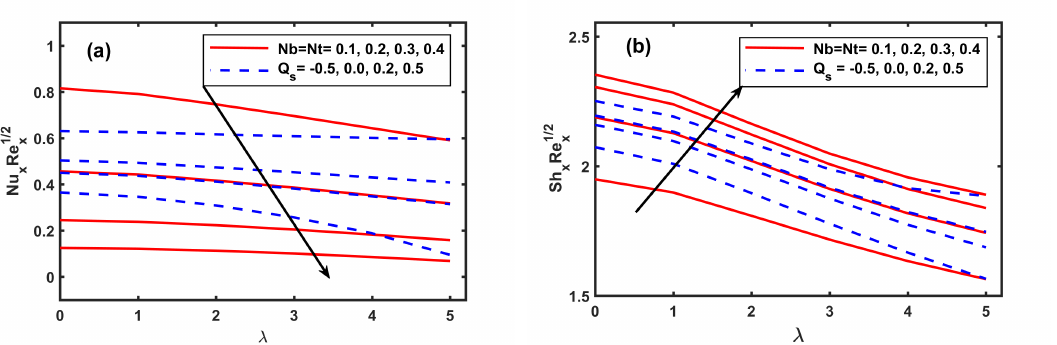
Figure 12. Fluctuation of Nu x Re 1/2 x and Sh x Re 1/2 x along with Nb, Nt, λ , and Q s .